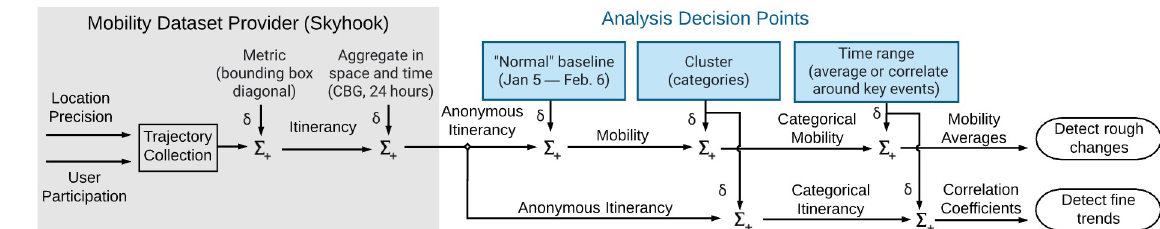
Fig 3. Conceptual diagram of analysis decision points. This paper quantifies how much imprecision can be introduced into final analysis depending on trade-offs at each decision point.